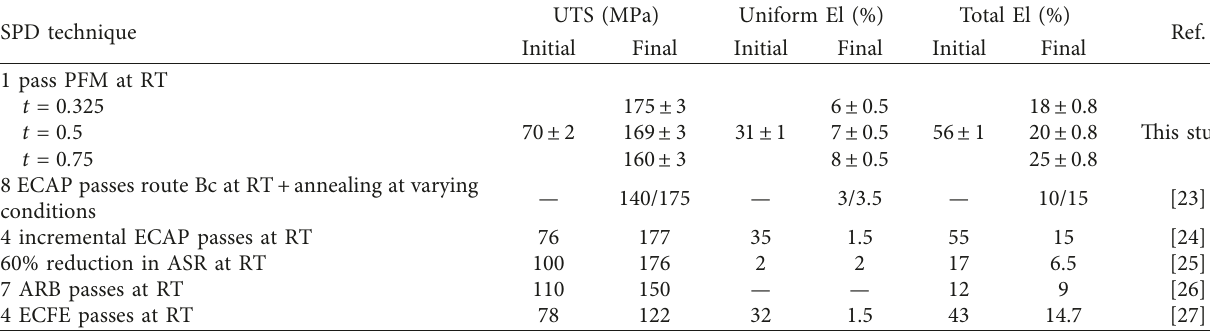
Table 1: Tensile test results on Al1050 preprocessed by different SPD